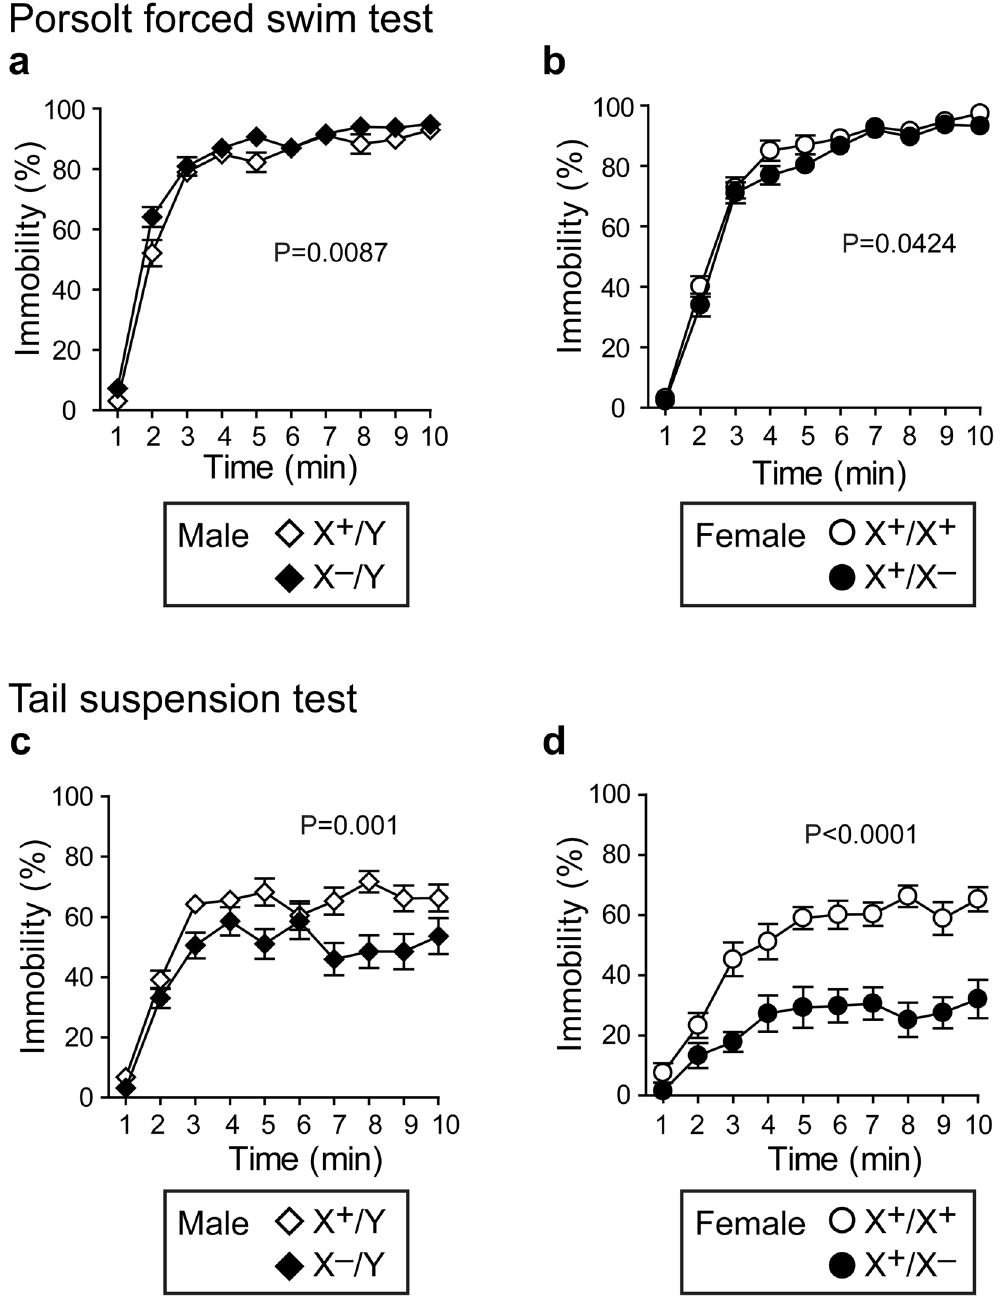
Figure 5. Altered behavior of Pcdh19 mutants in the Porsolt forced swim and tail suspension tests. ( a , b ) Porsolt forced swim test with male ( a ) and female ( b ) mice. ( a ) Pcdh19 hemizygous male mutants (X − Y) showed a significantly higher immobility rate ( a ) compared to wild-type male mice, whereas heterozygous female mutants (X + X − ) showed a lower immobility rate than wild-type female mice ( b ). ( c , d ) Tail suspension test with male ( c ) and female ( d ) mice. Both Pcdh1 9 hemizygous (X − Y) and heterozygous female (X + X − ) mutants showed a significantly lower immobility rate compared to wild-type